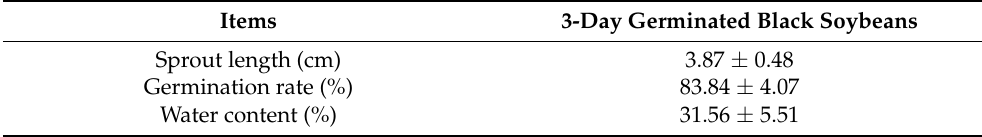
Table 1. The sprout length, germination rate, and water content of 3-day germinated black soybeans.